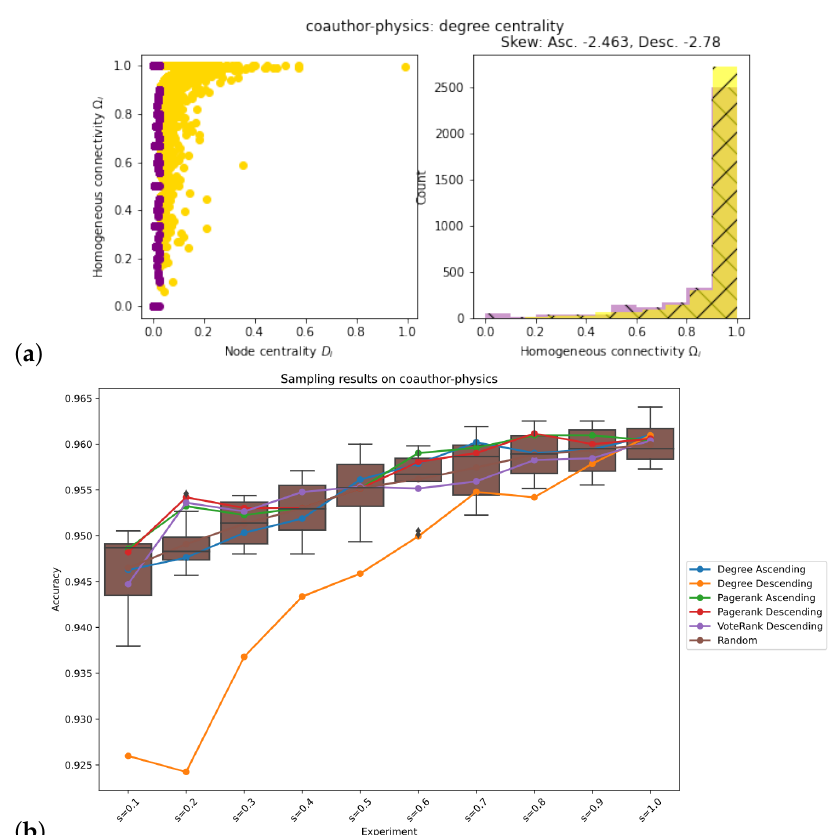
Figure A4. Panel ( a ) shows degree centrality plots where the left figure presents scatter plots of node degree centrality D i against node homogeneous connectivity Ω i on the training data of coauthor- physics. The upper half of nodes according to their centrality are colored in yellow while the lower half is presented in purple. The histogram on the right visualizes the distribution of homogeneous connections. The skew for each subset’s distribution is annotated above the right graph. Panel ( b ) presents the sampling result on the training data of